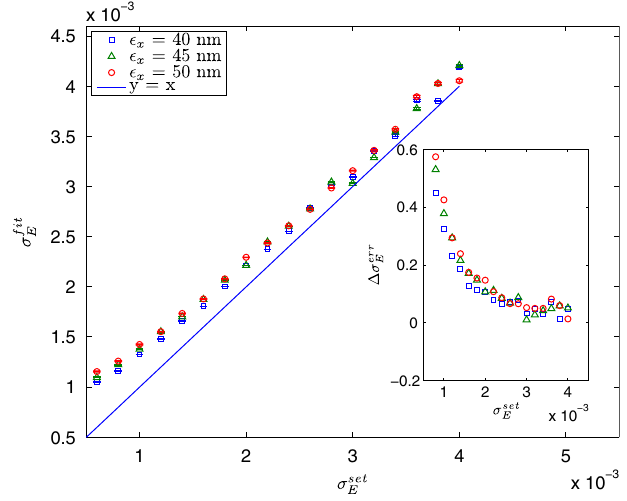
¼ 40 ; 45 ; 50 nm . x ¼ 31 . d